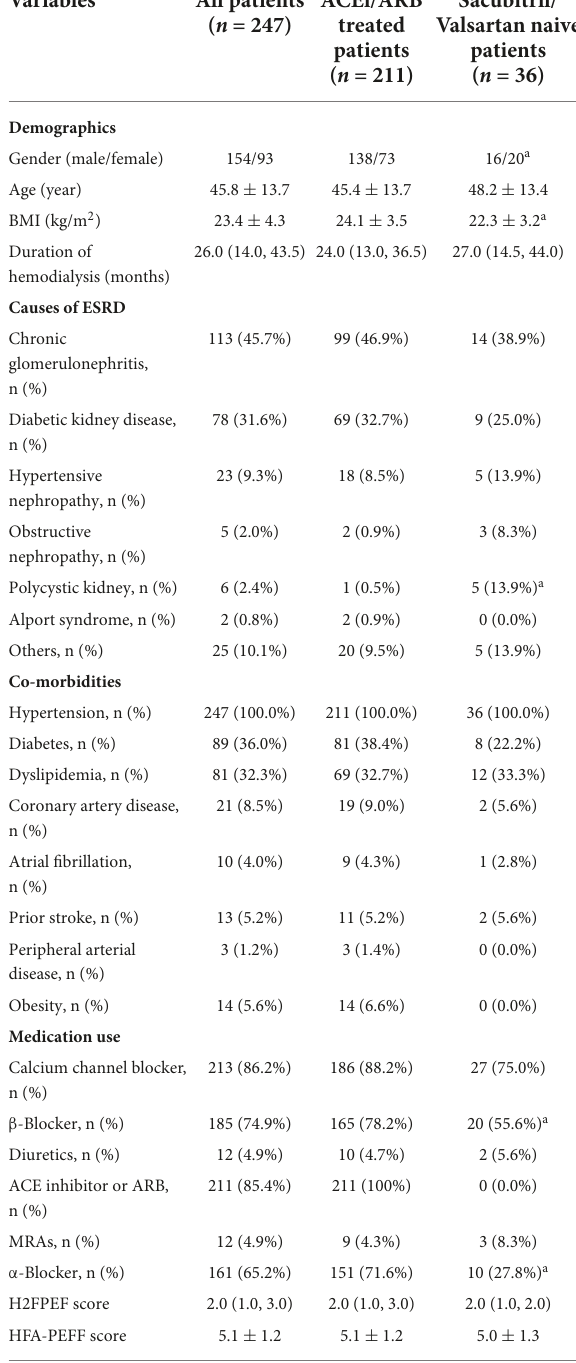
TABLE 1 Baseline characteristics of patients undergoing hemodialysis with HFpEF initially presenting before sacubitril/valsartan treatment. Variables All patients